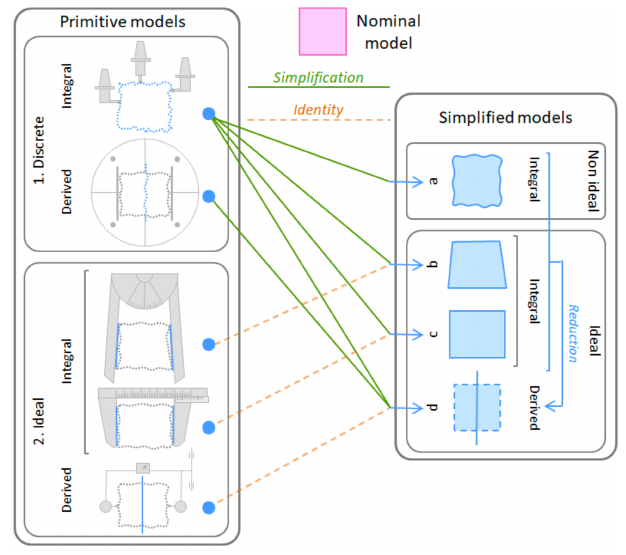
Figure 6. Part geometry models for